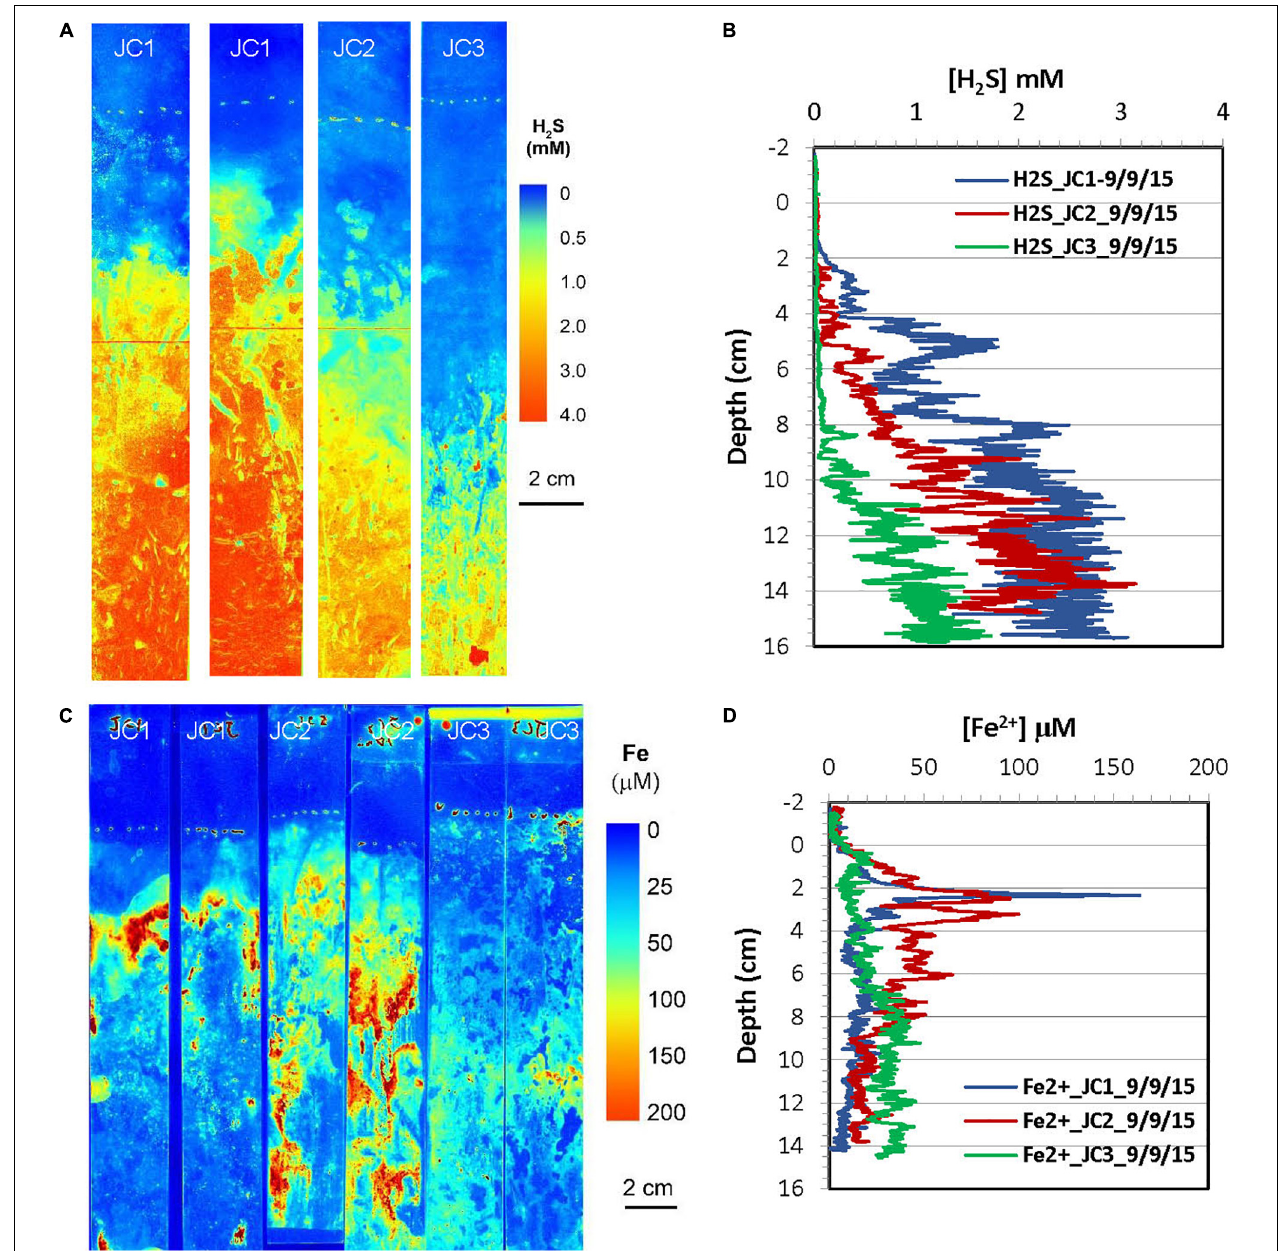
FIGURE 7 | H 2 S and dissolved Fe 2 + distribution patterns in the pore water of JoCo (JC) marsh peats in summer 2015. (A) 2-D H 2 S distribution patterns (pseudo color) obtained by in situ measurements in sediments; white line marks the peat surface. (B) Vertical H 2 S profiles averaged from each 2-D H 2 S distribution in the panel (A) . (C) 2-D Fe 2 + distribution patterns obtained by in situ deployments; white line marks the peat surface. (D) Vertical Fe 2 + profiles averaged from each 2-D Fe 2 + distributions in the panel (C)